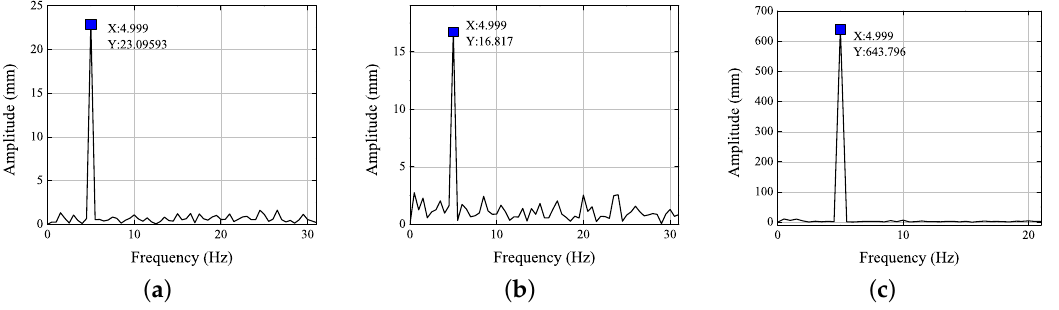
Figure 10. Frequency spectra of right eye in the ( a ) X , ( b ) Y , and ( c ) Z